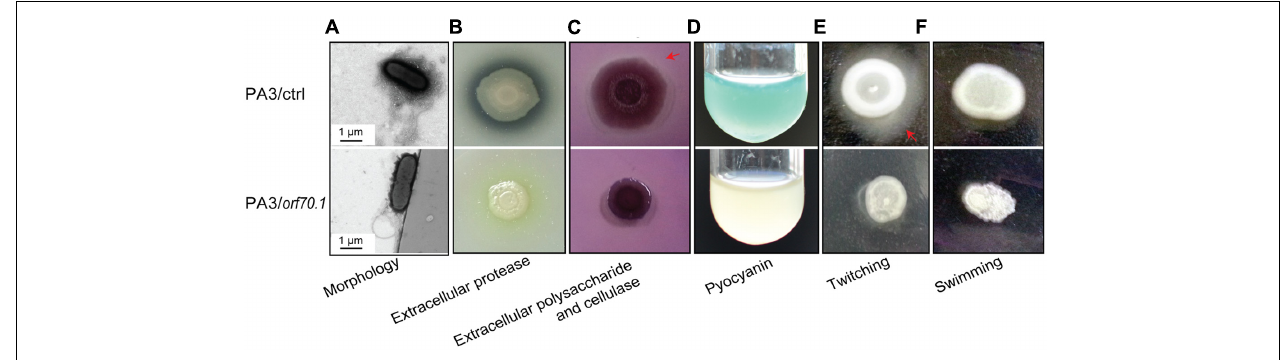
FIGURE 7 | Phenotypic analyses of P. aeruginosa (PA3/ctrl and PA3/ orf70.1 ). (A) Transmission electron microscope image. (B,C) Detection of extracellular protease, polysaccharide and cellulase of P. aeruginosa on LB plates containing 2% milk or 0.1 congo red. (D) Pyocyanin of P. aeruginosa in LB medium. (E,F) Motility experiments on LB plates with 1% agar for twitching and 0.3% agar for